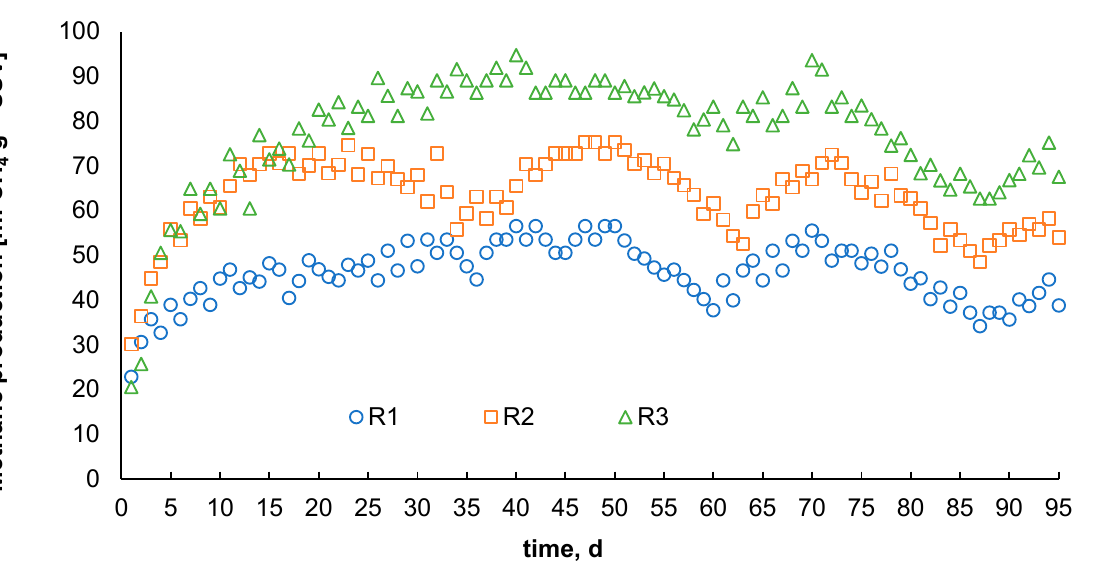
Figure 4. Profile on time of methane production for the R1 (control), R2 (thermal pre-treatment), and R3 (micro-aerobic pre-treatment) digesters at 20, 15, and 10 days of HRT.